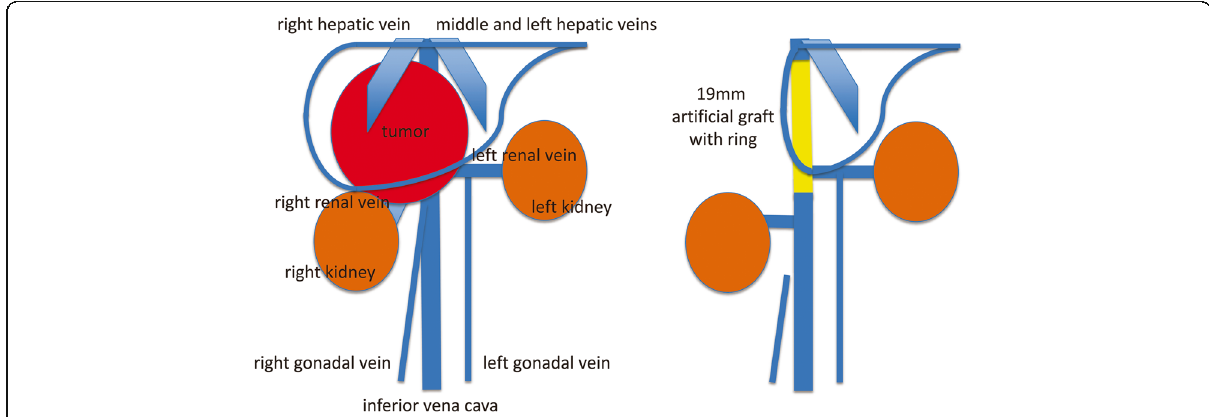
Fig. 3 Schema of the preoperative state (left) and postoperative state (right). Surgical procedures of venous reconstruction are as follows: (1) right gonadal vein ligation, (2) right renal vein reconstruction by suturing to the native IVC, (3) IVC reconstruction replaced by the artificial graft, and (4) left renal vein reconstruction by suturing to the artificial